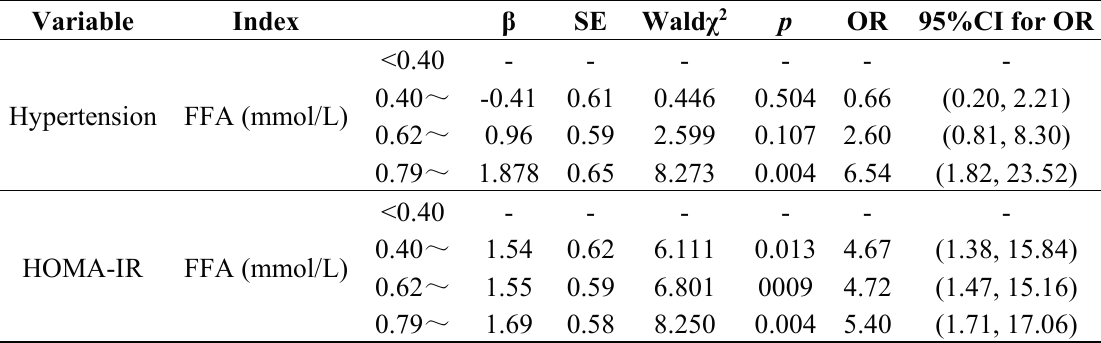
Table 5. Multivariate logistic regression analysis of FFA levels with hypertension and